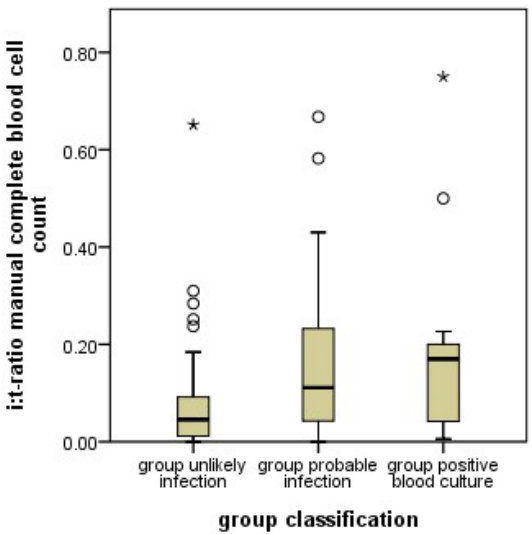
Figure 5. Boxplot of the I/T-ratios (number of manually counted immature granulocytes divided by the total number of granulocytes) in the unlikely infection (UI), probable infection (PI) groups, and the positive blood culture (PC) subgroup. The PI group had higher I/T-ratios than the UI group ( p < 0.001). The boxes show median, and interquartile range, the whiskers 95% confidence range, ○ = outliers, ★ = extreme outliers.